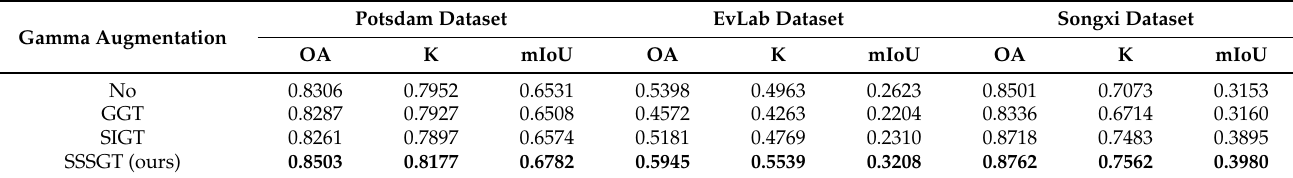
Table 4. Performances of different gamma-transform-based data augmentation applied on SDFCNv2 model equipped with SCFSE module in three datasets. Gamma